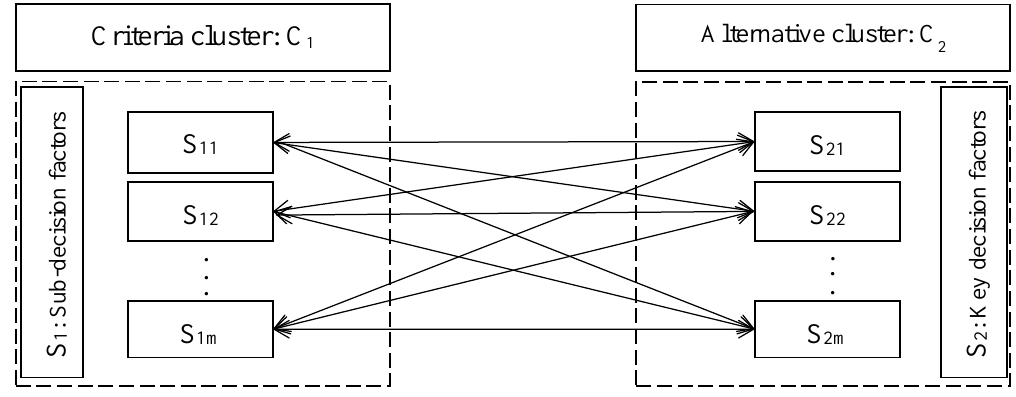
Figure 2. Analytic network process (ANP) model structure.